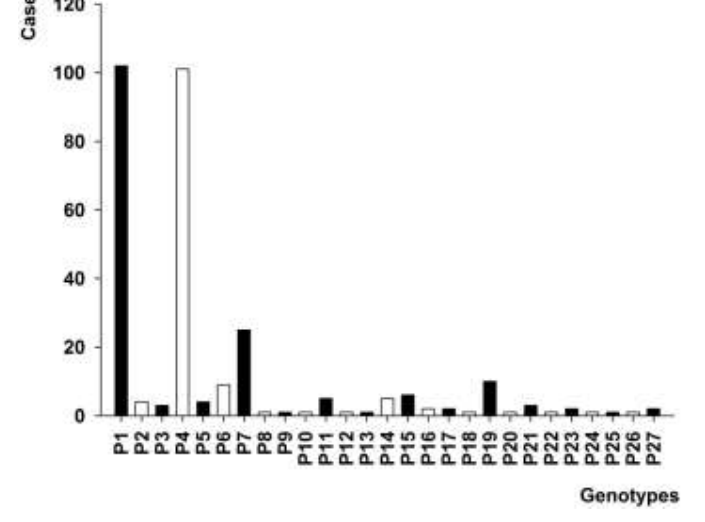
Figure 2. PFGE profile of 296 A. baumannii isolates positive for intl1